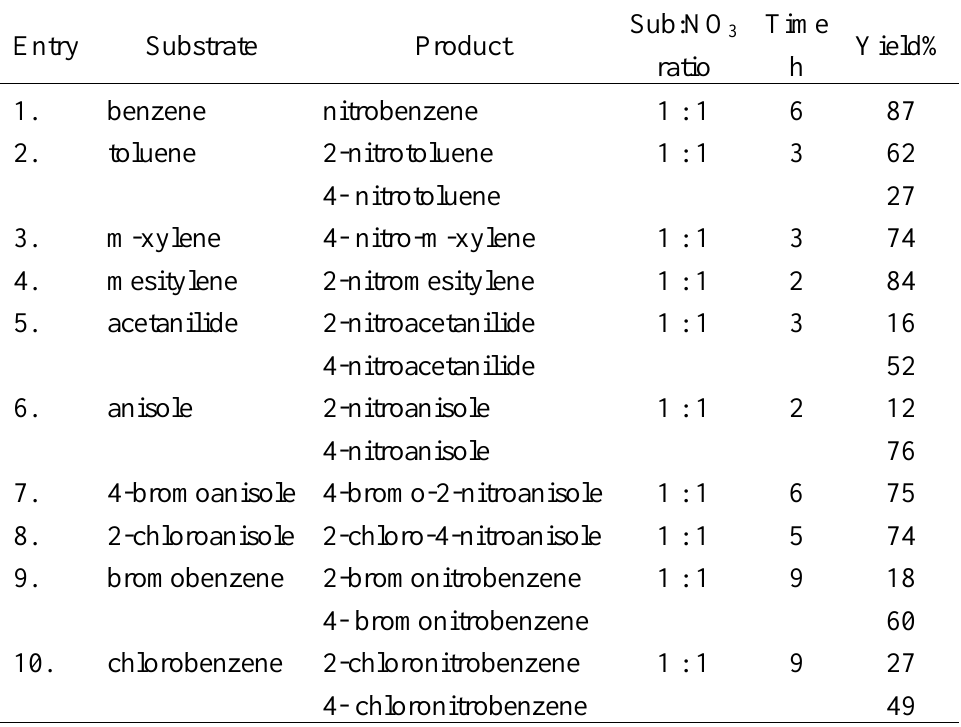
Table 1. Nitration of Some Aromatic Compounds with Bismuth Subnitrate